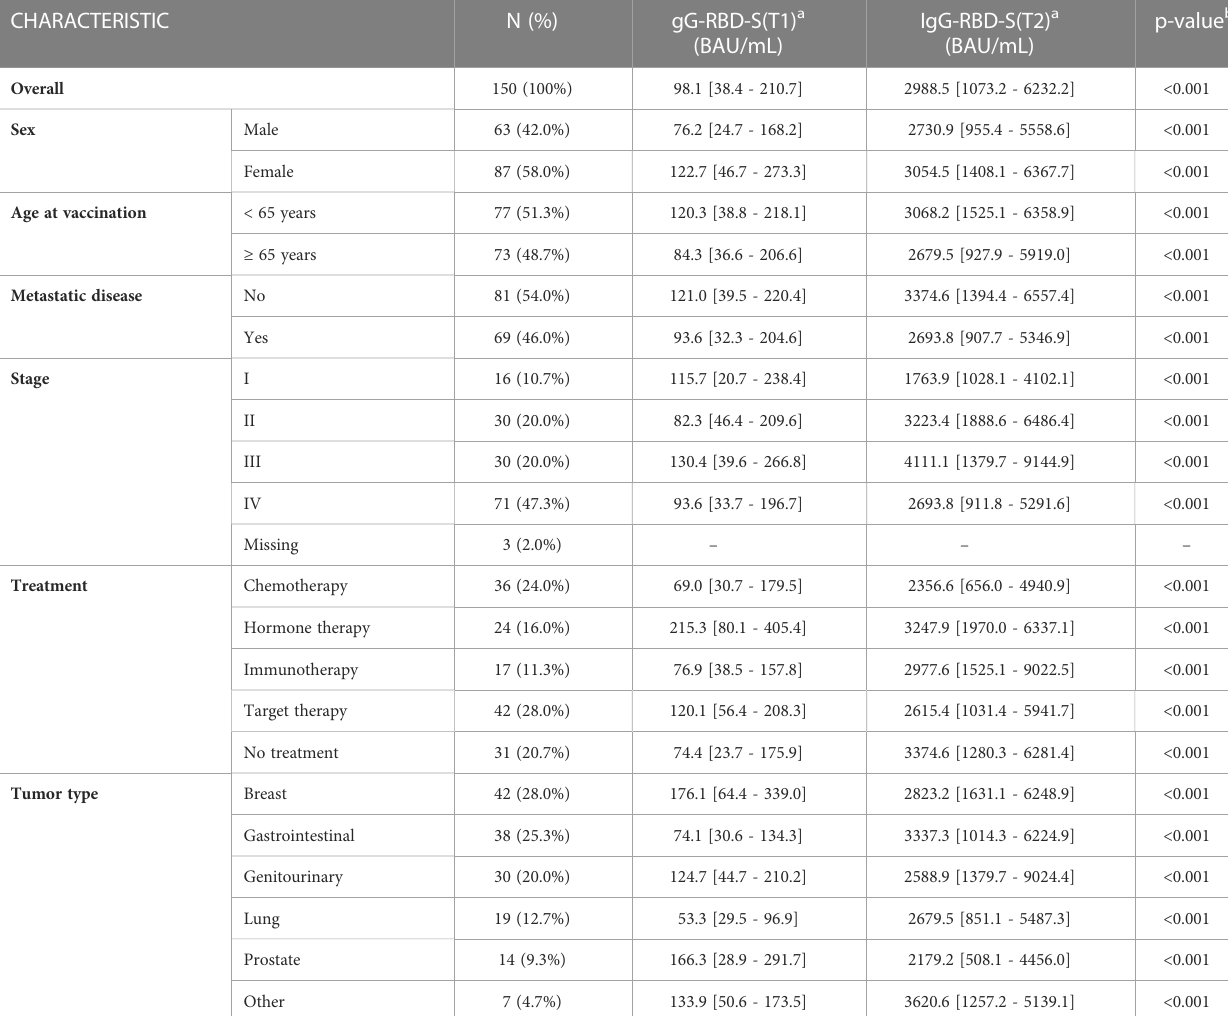
TABLE 2 IgG-RBD-S value across groups for paired data at T1 (6 months after primary series of COVID-19 vaccine of vaccine) and T2 (3 weeks after third dose of vaccine).